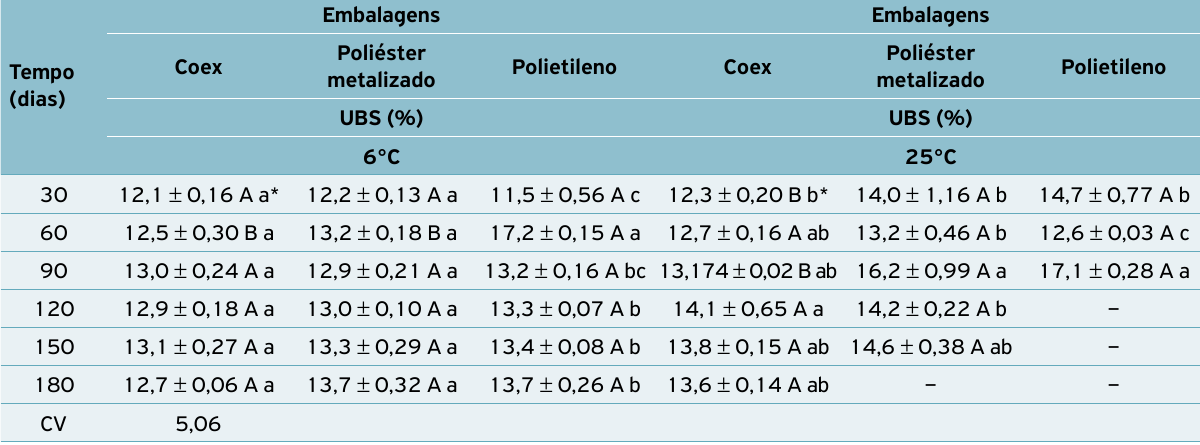
Tabela 4. Média e erro padrão do conteúdo de água (umidade em base seca) de uma mistura granulada com conídios de B. bassiana acondicionada em 3 tipos de embalagens armazenadas em refrigerador (6 ± 2°C) e em câmara climatizada (25 ± 1°C) durante 180 dias.